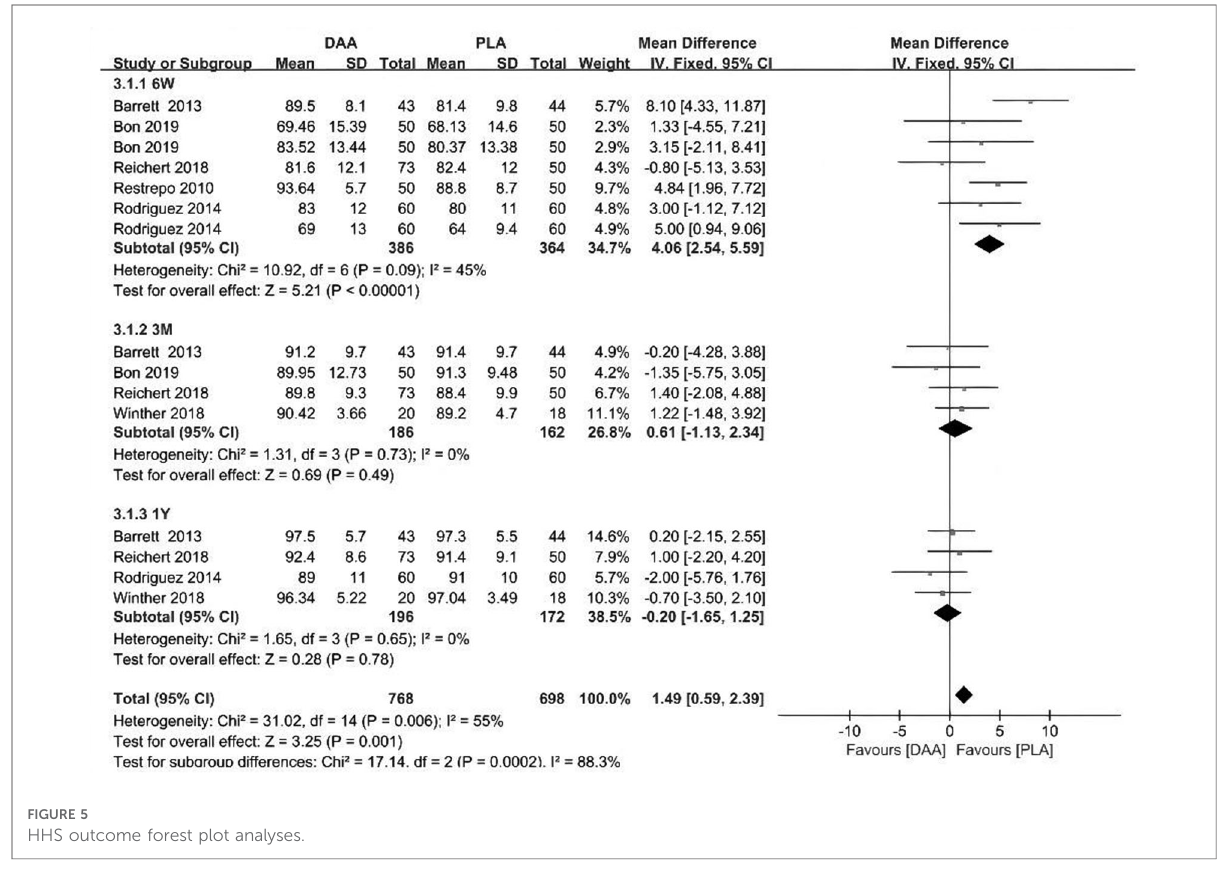
FIGURE 5 HHS outcome forest plot analyses.